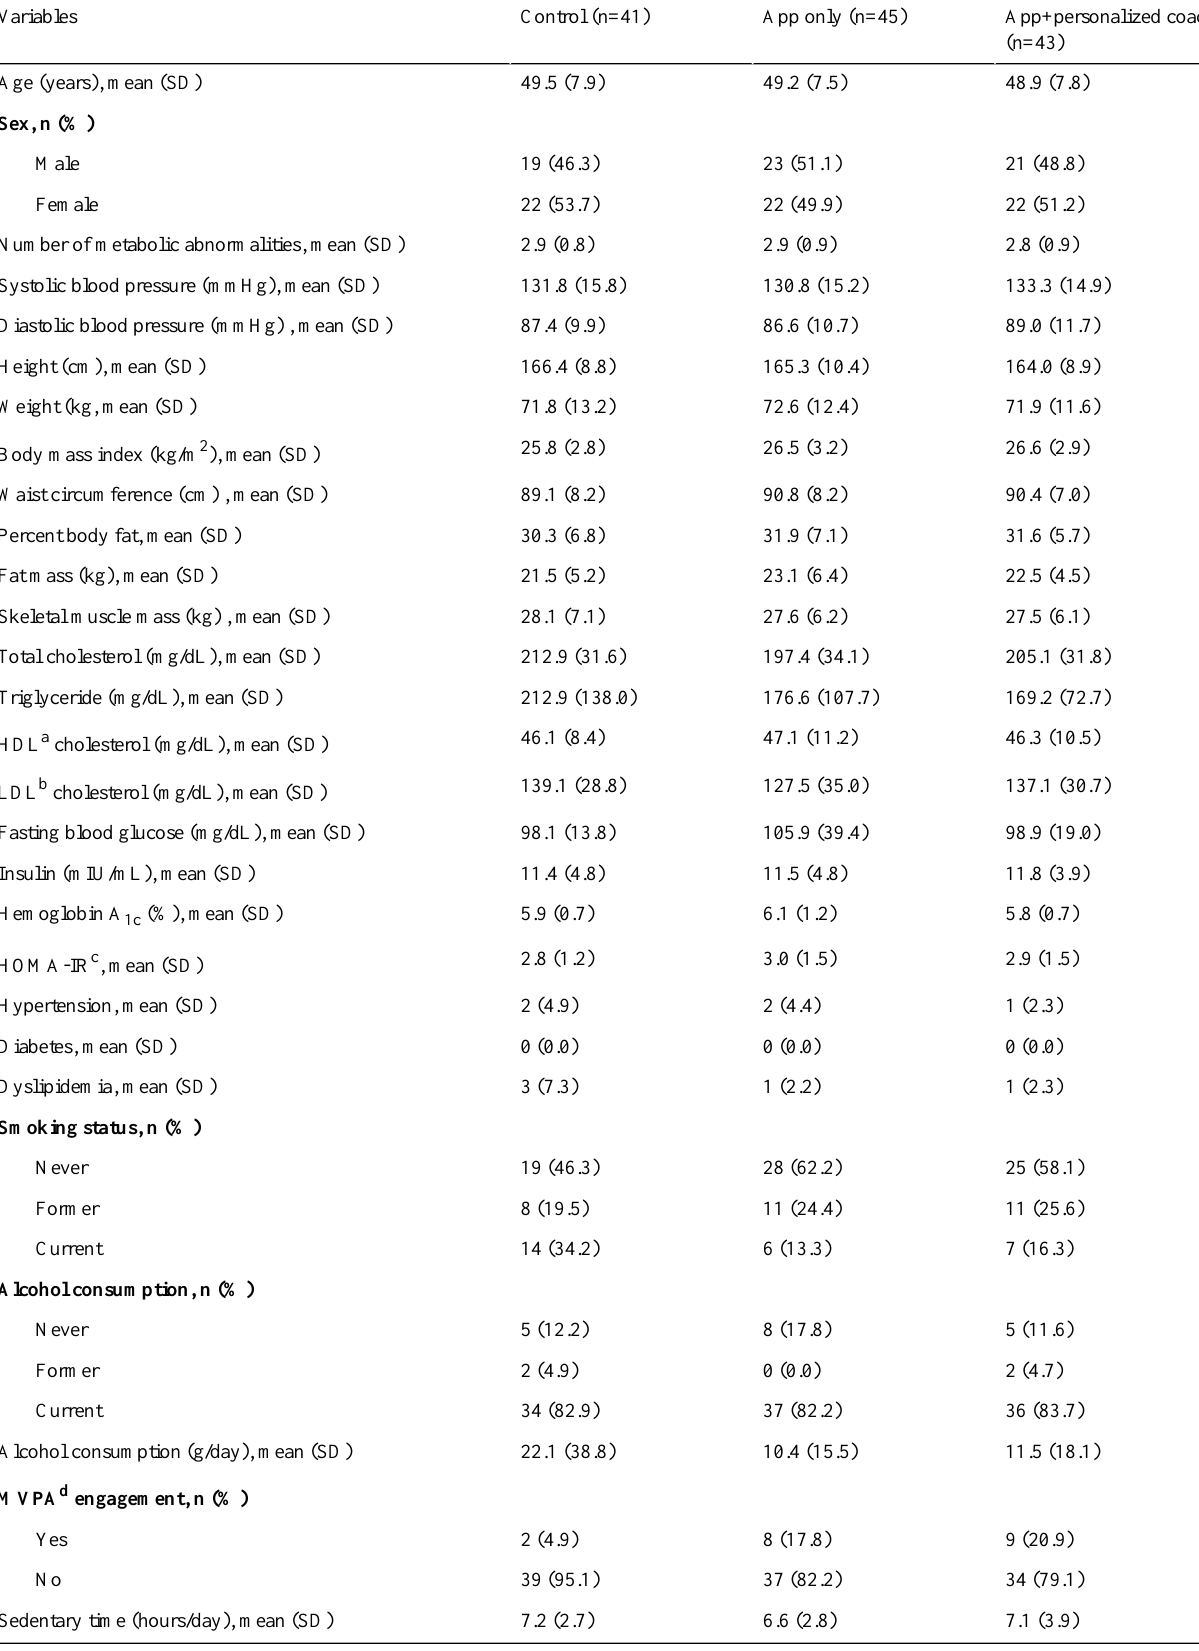
Table 1. General characteristics of the study participants at the baseline